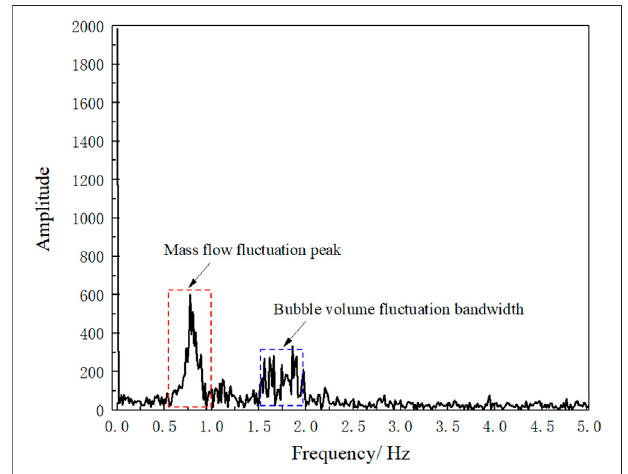
FIGURE 9 | Amplitude-frequency diagram obtained by Fast Fourier Transform